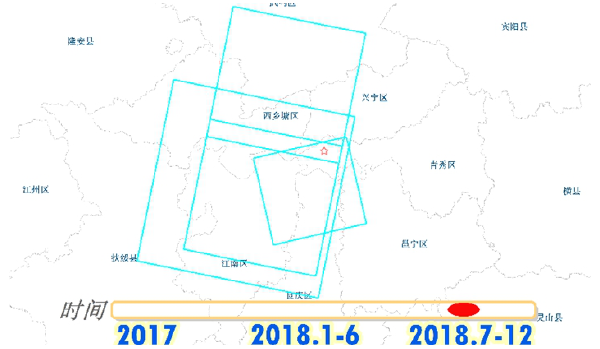
Figure 5. The query of a star point shown on the map